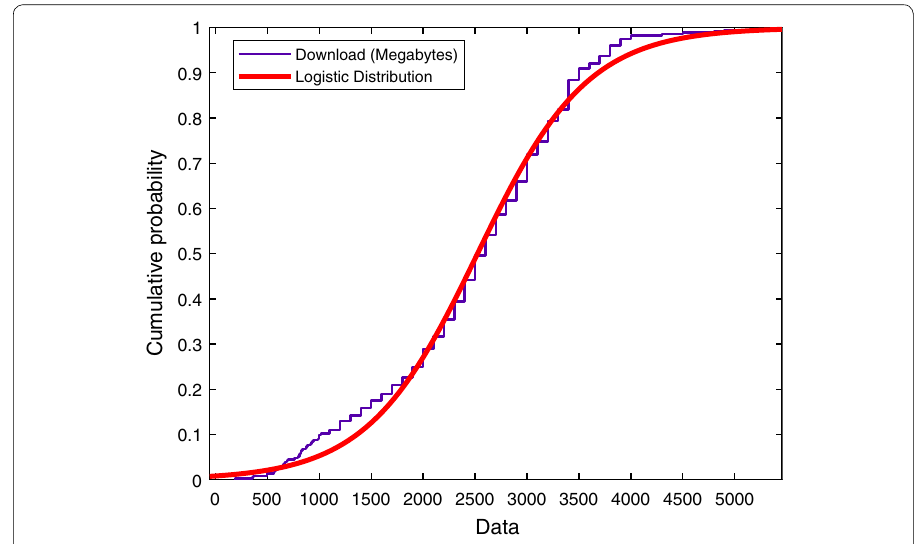
Fig. 7 Cumulative probability plot of the internet download traffic